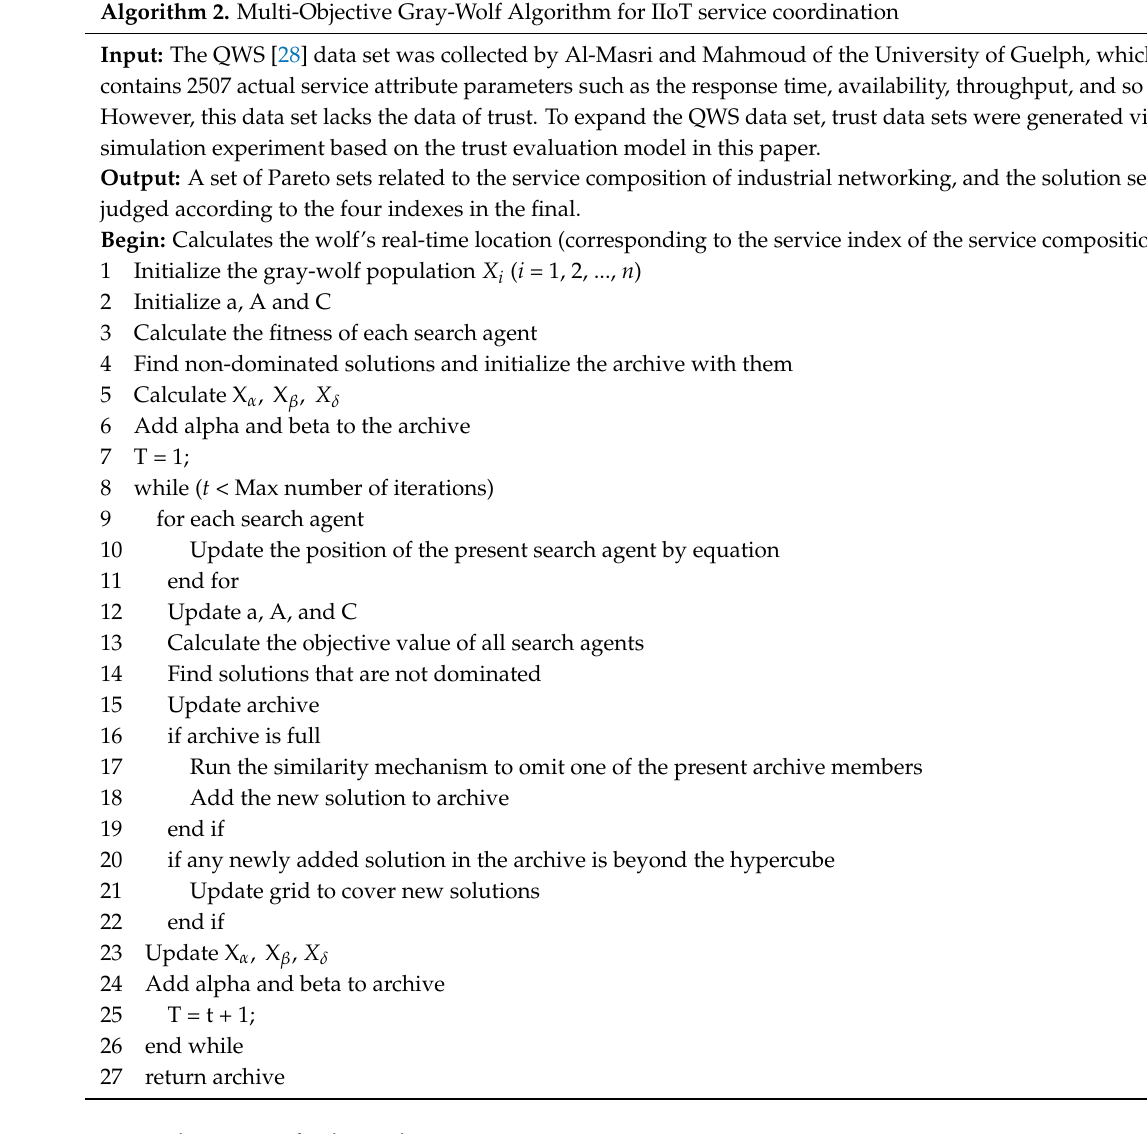
Algorithm 2. Multi-Objective Gray-Wolf Algorithm for IIoT service